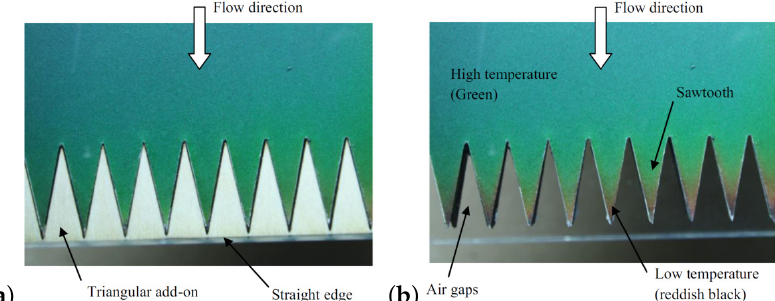
Figure 13. Captured raw active liquid crystal images (redrawn from [134], reddish black color and green color denote low temperature and high temperature, respectively) for: ( a ) the baseline trailing edge (serrated trailing edge with triangular add-on); and ( b ) the serrated trailing